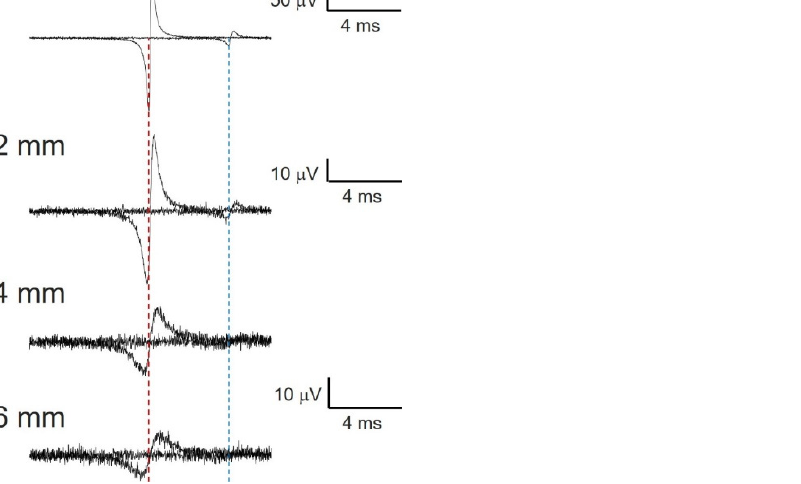
Figure A1. Numerical simulation of compound nerve action potential for myelinated (40 m/s) and unmyelinated fibers (10 m/s). Dipole length (d) = 1 mm and 0.1 mm for myelinated and unmyelinated fibers, respectively. Dotted red line centered at the first positive spike for upper trace. Dotted blue line centered at second positive spike for the same trace. Note the effect of distance on the fastest nerve conduction velocity, derived from the longer duration of total positive deflection, which delays the most positive value.